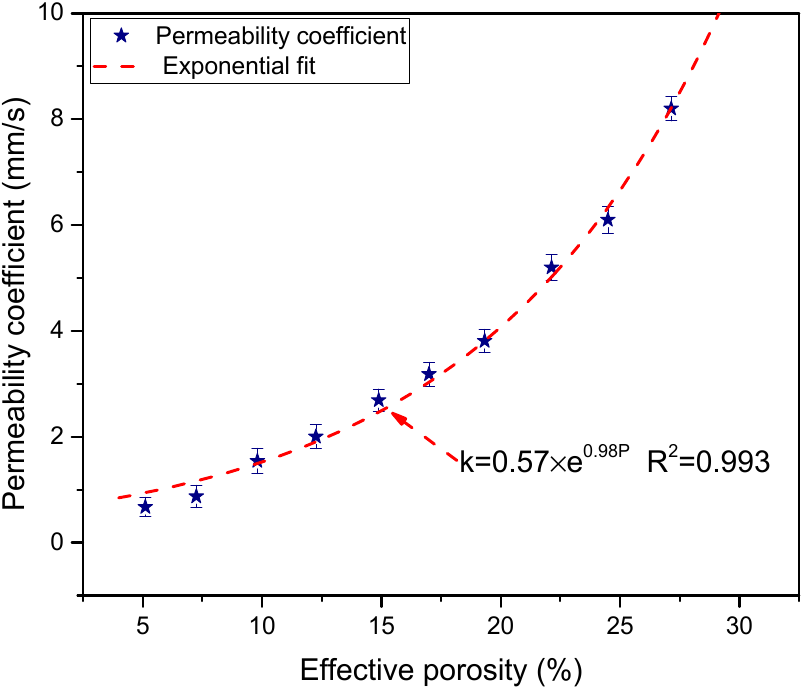
Figure 9. Permeability Coefficient of the pervious concrete and its relationships versus the effective Figure9. porosity.